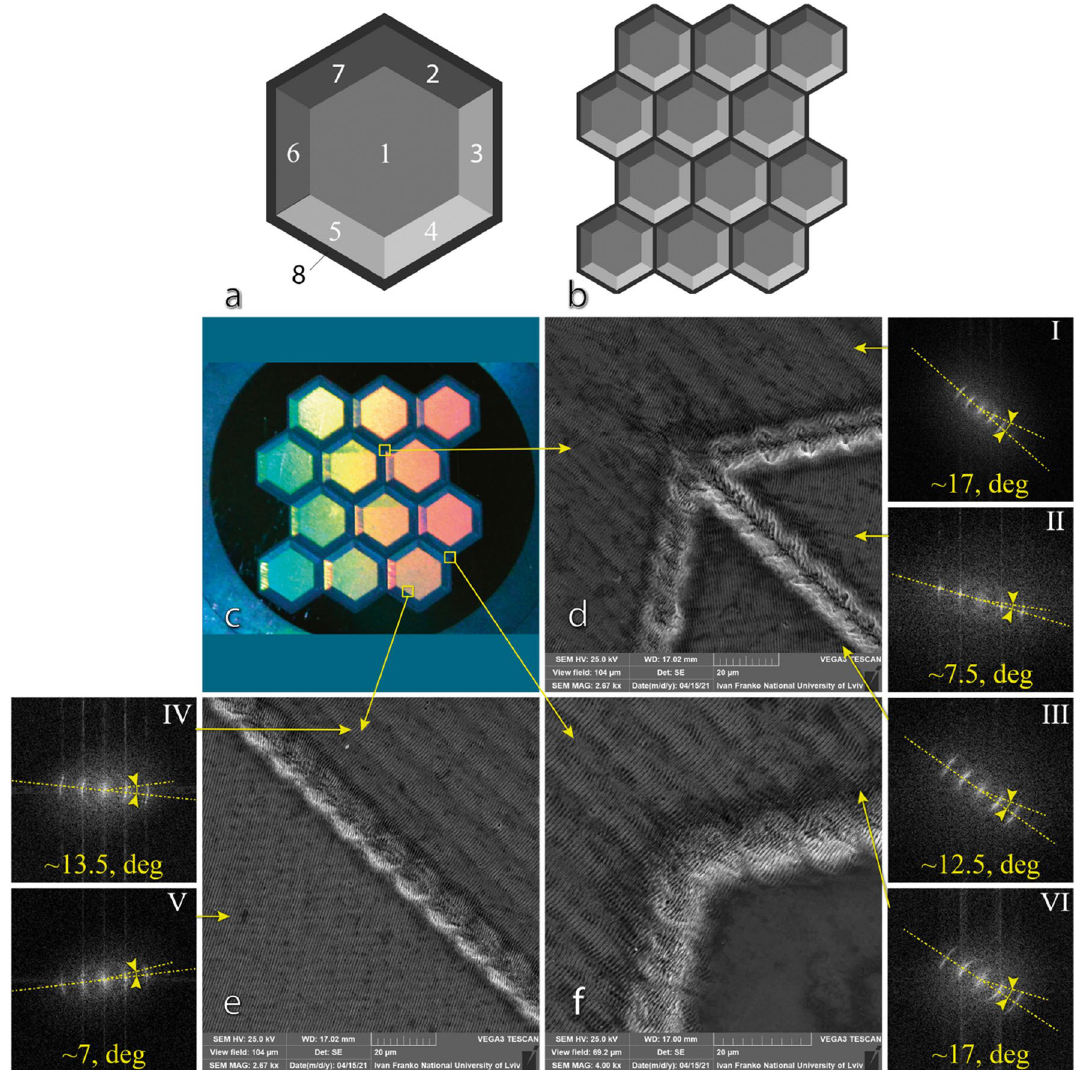
Figure 1. Input vector image ( a ) and SEM-image of different segments of the hologram with Fourier transforms and determination of the approximate angle of orientation of nanostructures ( b ) Recorded quasi- hologram ( c ) and SEM images of different parts of the hologram ( d – f ). Insets I–VI indicate dispersion LIPSS orientation angle (DLOA) for various segments of 13.336 J/cm 2 . As an input, we used the image with a dimension of 200 × 200 (see Fig. 3a). The quasi-hologram with a size 10 × 10 mm recorded on the steel surface is shown in Fig. 3 (b). SEM images corresponding to the different brightness levels are also shown (Fig. 3I–III). Taking into account the parameter "value" of the HSV color model, we can distinguish three main zones cor- responding to different orientations of LIPSS: low brightness zone has V in the range 40–100, corresponding to structures of type (a) (see Fig. 2b); in the intermediate brightness zone V varies from 120 to 200 and corresponds to structures type (b); for the brightest zone V is in the range of 220–250 for structures of type (c). SEM images of different zones of the hologram are shown in Fig. 4. From Fig. 4 one can see how the orientation of the LIPPS changes during dynamical rotation of the incident laser beam polarization. The SLM matrix enables relatively rapid switching of polarization vector compared to standard approaches, which use rotation of the half-wave plate. This allows continuous recording of single image with high resolution. However, to provide this for a constant area and SLM refreshing rate we must reduce the recording speed. DLOA of segments on Fig. 4a–c depicted by insets I–V is equal to 22°–29° that reveal LIPSS of low regularity. These results suggest a possible distortion between laser source and SLM during their synchro- nization. However, we have demonstrated on Fig. 4 the possibility of obtaining non-symmetrical LIPSS, which can find a potential application in obtaining non-symmetrical quasicrystals 35 .